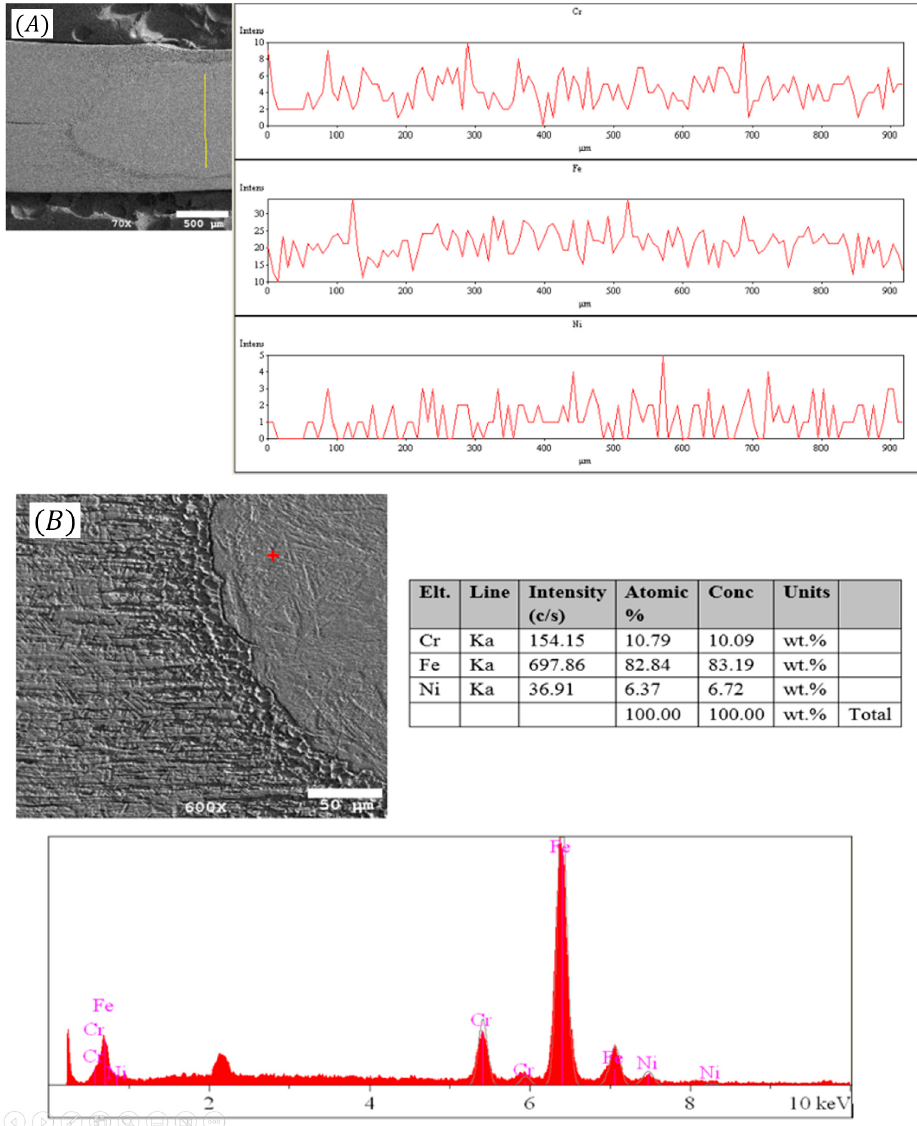
Figure 11. ( a ) Linear EDS analysis of distribution of Fe, Cr and Ni elements in the weld zone, ( b ) point EDS analysis of weld nugget.